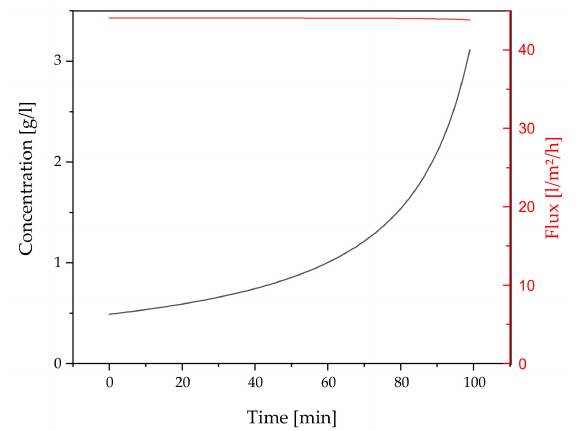
Figure 13. Concentration to final volume of 100 L and 3.1 g/L titer after addition of 9 DV. Filtration is performed at a constant flux. This results in an exponential increase of the concentration. A 5-fold increase in concentration is achieved after 90